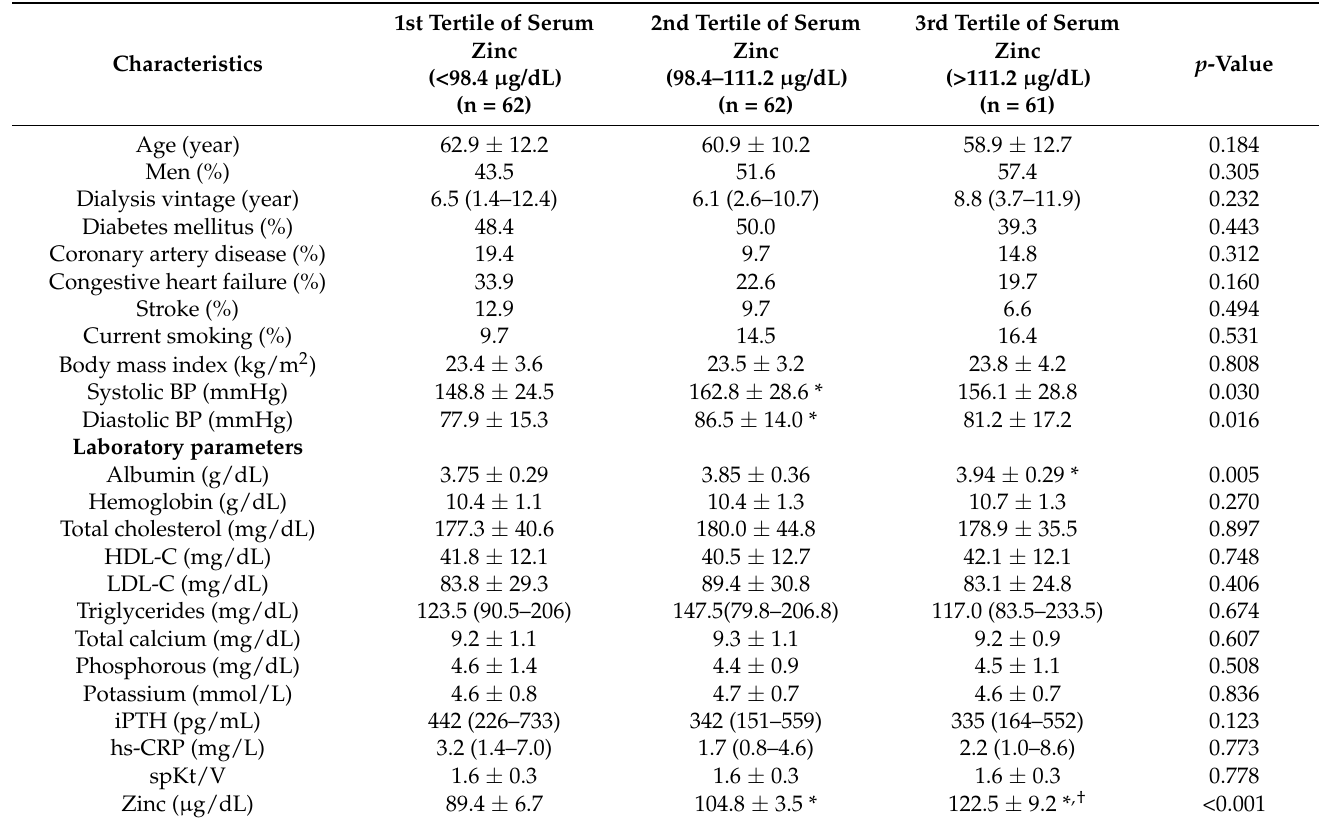
Table 1. Comparison of baseline characteristics among study patients classified by tertiles of serum zinc level.